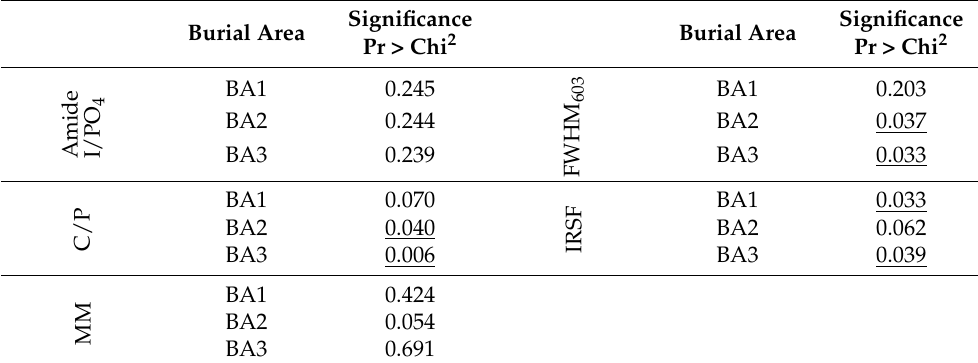
Figure 6. Multinomial logistic regression curves of probability of the burial area (BA1, BA2, and BA3 for the humans and ENV for the modern ruminants), with the following spectral diagenetic parameters: ( A ) Amide I/PO 4 , ( B ) C/P, ( C ) MM, ( D ) FWHM 603 , and ( E ) IRSF. Table 3. Results of the multinomial logistic regression analysis performed to assess the association between amide I/PO 4 , C/P, MM, FWHM 603 , and IRSF indexes and the burial area. Statistical significance was set at <0.05 and was calculated as the probability of the chi-square test on the log ratio. Significant values are underlined.